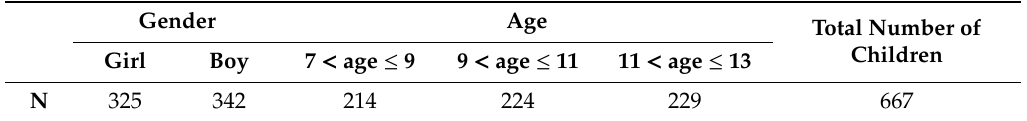
Table 1. Gender and age distribution.